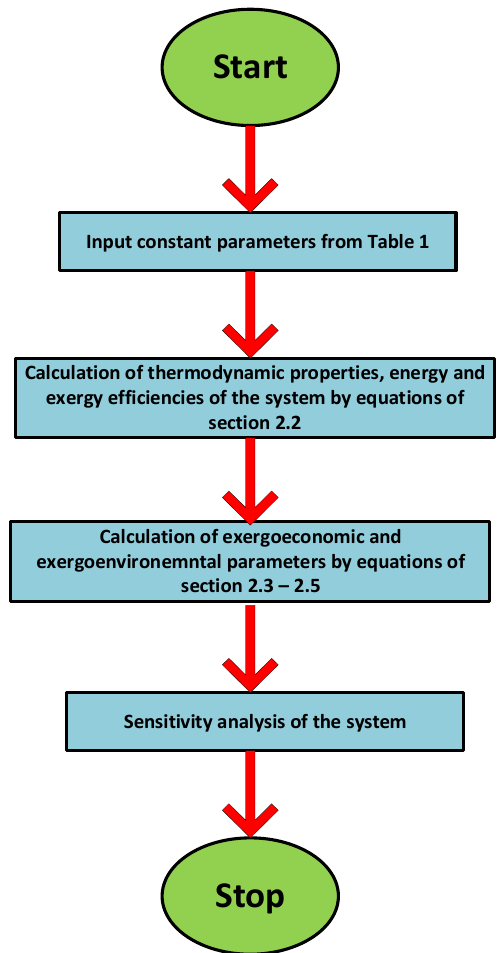
Figure 3. Mathematical modeling flowchart of the system.